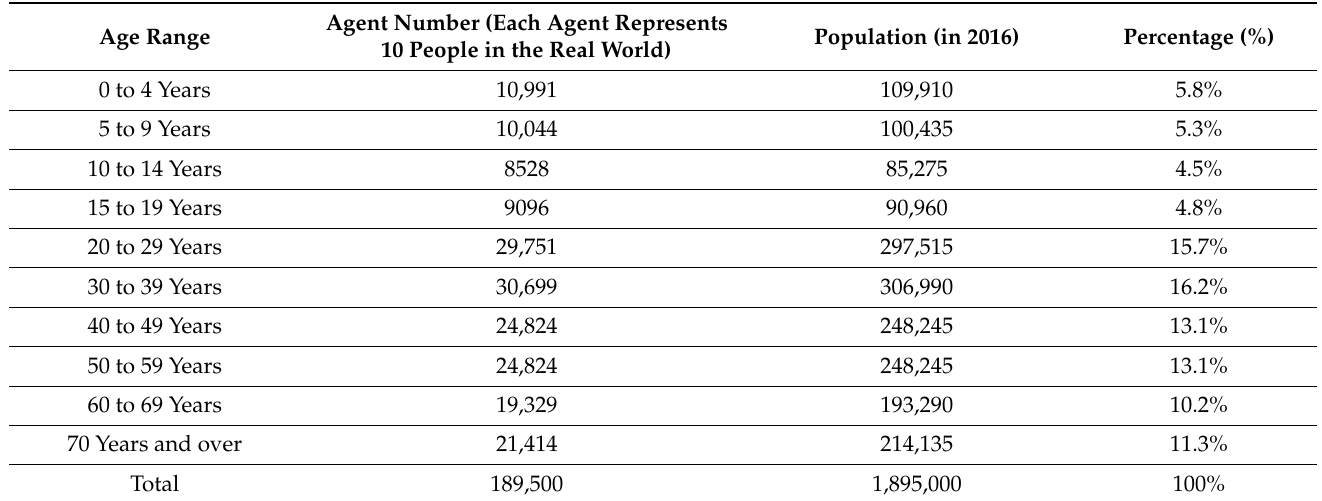
Table A1. The population of Montreal city based on age (the year 2016).